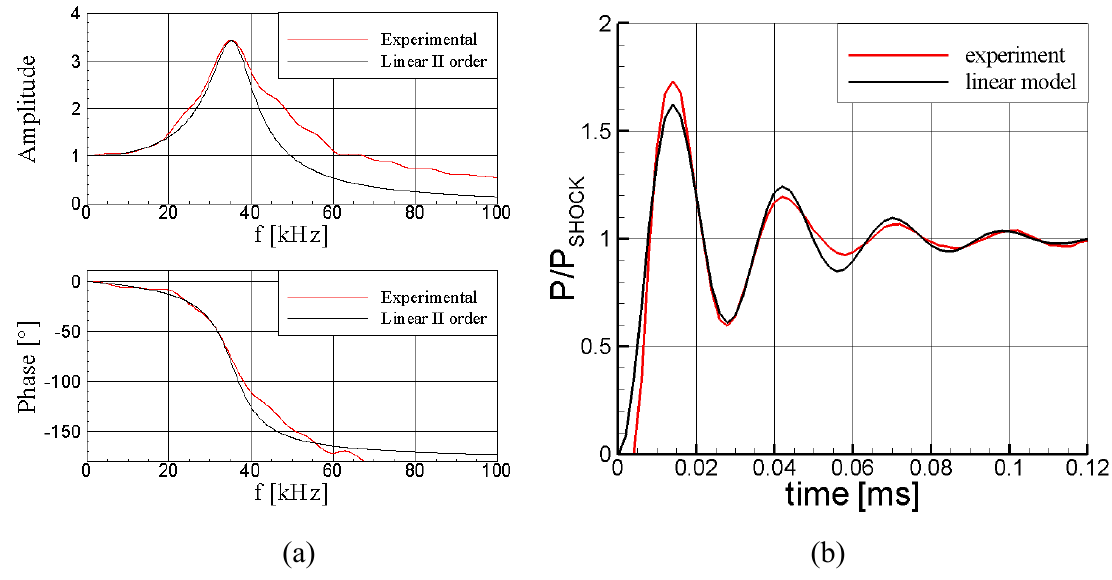
Figure 7. Frequency-domain ( a ) and time-domain ( b ) identification of a typical FRAPP.